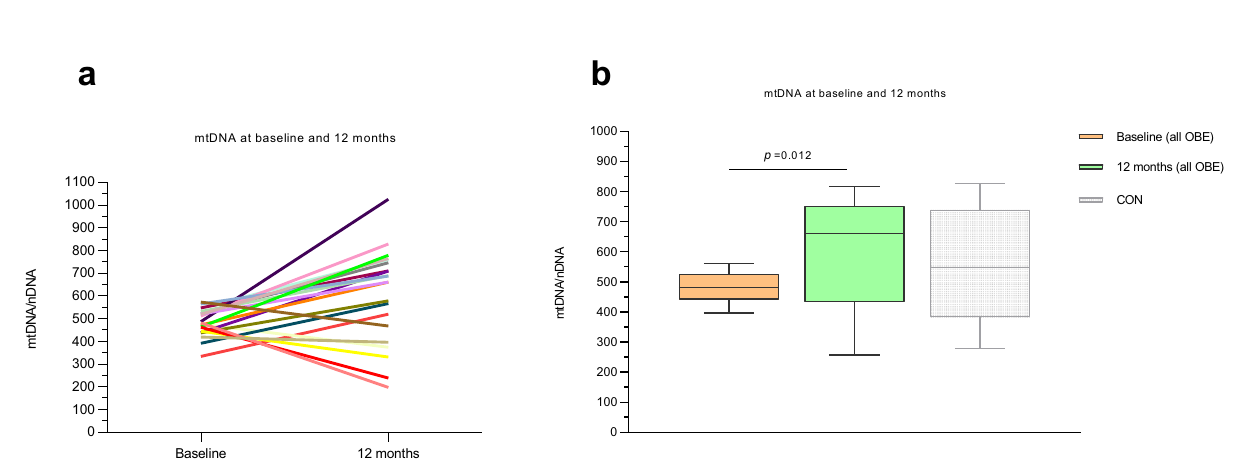
Fig. 6 Mitochondrial DNA/nuclear DNA content in hepatic tissue from the 21 patients with obesity at baseline and 12 months later. a spaghetti plot. b median mtDNA/nDNA at the two timepoints. CONs (baseline) are also shown. No statistically signi fi cant differences were found between CONs and OBE 12 months after surgery. Data are median (horizontal line), interquartile range (boxes) and 10 – 90% percentile (error bars). P -values (2-sided) are Wilcoxon-signed rank test. Orange boxes; OBE baseline, green boxes; OBE 12 months after surgery, grey boxes (dimmed); CON ( n < 10) at baseline. Speci fi c n ’ s in each protocol and for each substrate and timepoint are provided in the Source Data fi